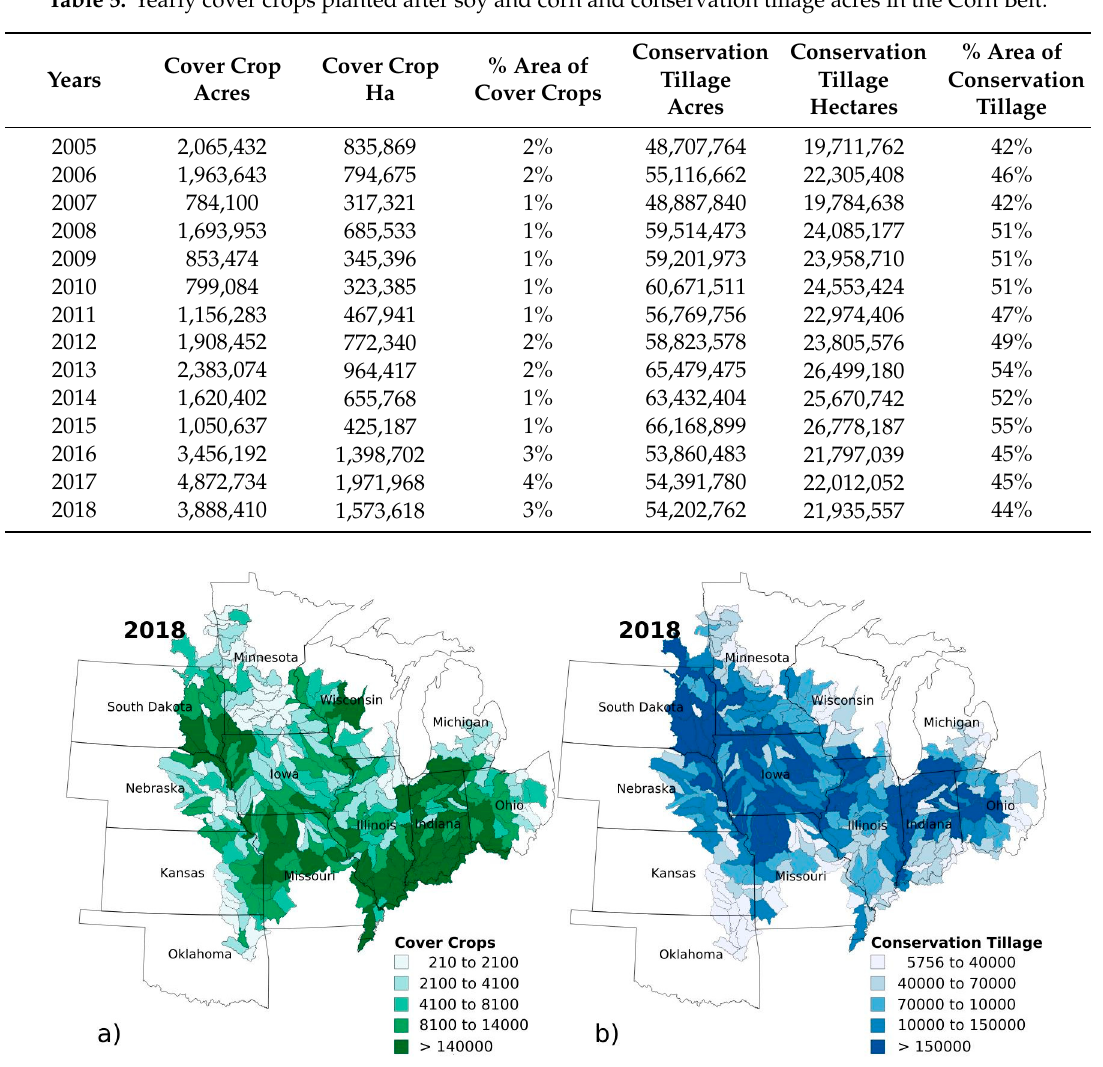
Table 5. Yearly cover crops planted after soy and corn and conservation tillage acres in the Corn Belt. Cover Crop Cover Crop % Area of Years Acres Ha Cover Crops